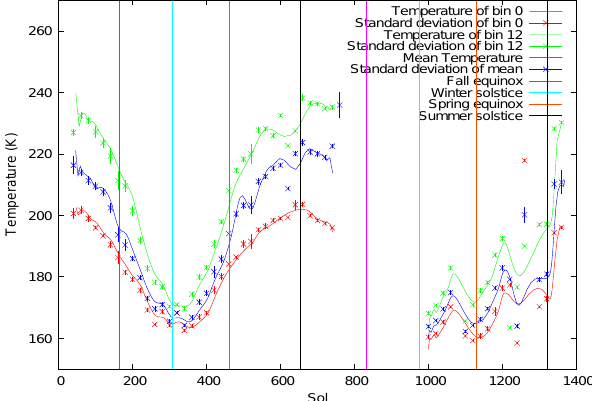
Fig. 7. ULT temperature data of a 4.93-h morning period of VL1 sol